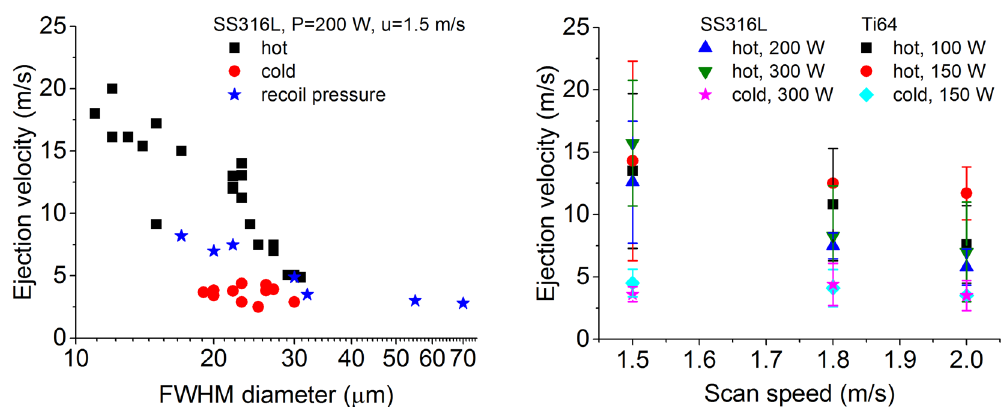
Figure 6. ( a ) Velocity-size distribution for SS316L at P = 200 W, u = 1.5 m/s. Hot-entrained ejections (black squares) had projected velocities ranging from ~6 m/s for 30 µ m particles to ~20 m/s for 10 µ m particles. Cold- entrained ejections (red circles) had projected velocities ranging from 2 to 4 m/s. Melt pool ejections (from recoil pressure and not involving an entrainment effect) had projected velocities ranging from 3 to 8 m/s. ( b ) Velocity as function of scan speed for SS316L and Ti64 at different laser